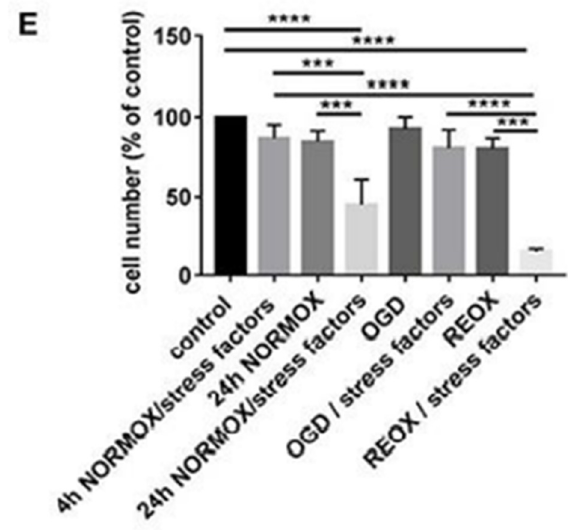
Figure 5. Loss of morphological integrity of cEND cells exposed to elevated catecholamine levels and inflammatory mediators. Immunofluorescence staining of tight junction proteins claudin-5 (green) and ZO-1 (red) as markers of morphological changes of the endothelial cell monolayer. DAPI (blue) was used to stain nuclei. Cells were grown on cover slips to confluence. After differentiation, cEND cells were treated with a combination of catecholamines and inflammatory mediators (stress factors). Stress factors were administered under different incubation conditions. Magnification 400×, scale bar 20 μ m. ( A ) Stress factor application for 4 h under normoxia conditions (4 h NORMOX). ( B ) Stress factor application for 24 h under normoxia conditions (24 h NORMOX). ( C ). Stress factor application for 4 h under oxygen glucose deprivation (OGD) conditions. ( D ) Stress factor application for 4 h under OGD conditions with 20 h of subsequent reoxygenation under normoxia conditions (REOX). ( E ) Cell number in treatments shown in panels ( A – D ) normalized to control. *** p < 0.001, **** p < 0.0001. From [95].